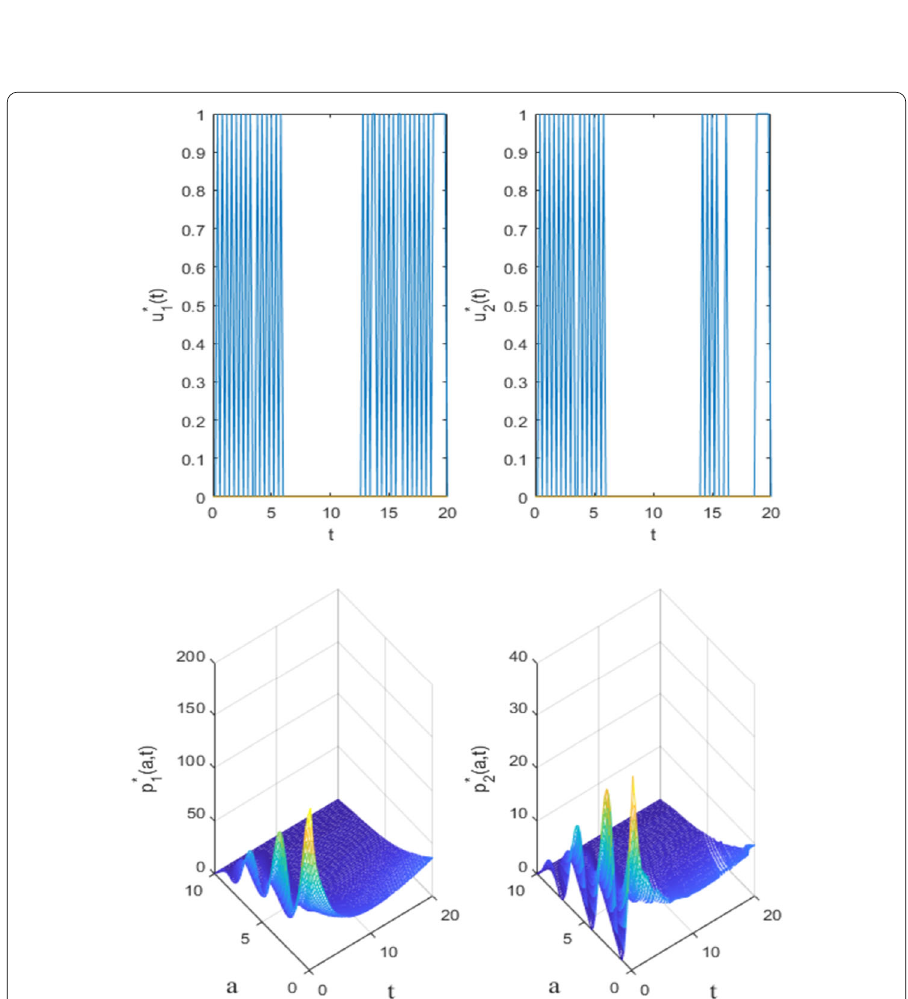
Figure 2 Optimal controls u ∗ 1 , u ∗ 2 and optimal densities p ∗ 1 , p ∗ 2 with s =